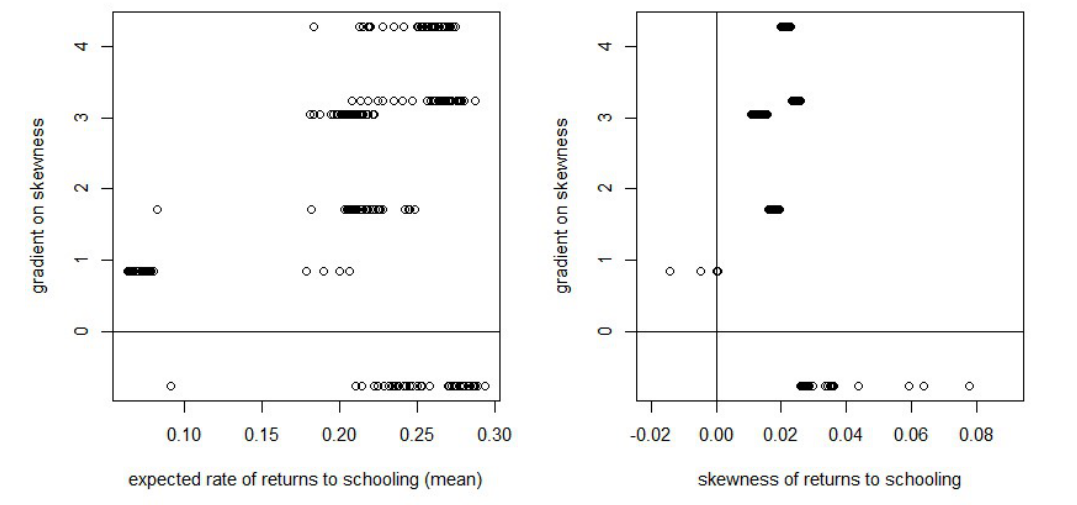
Figure 11. Spline gradients on skewness from Step 4: Stat. Sign. Only.